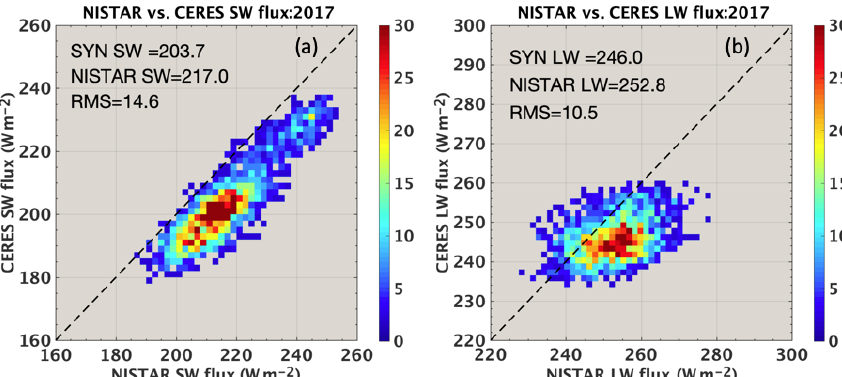
Figure 9. Comparison of coincident hourly SW and LW fluxes from NISTAR and CERES SYN1deg for 2017. The color bar indicates the number of occurrences.